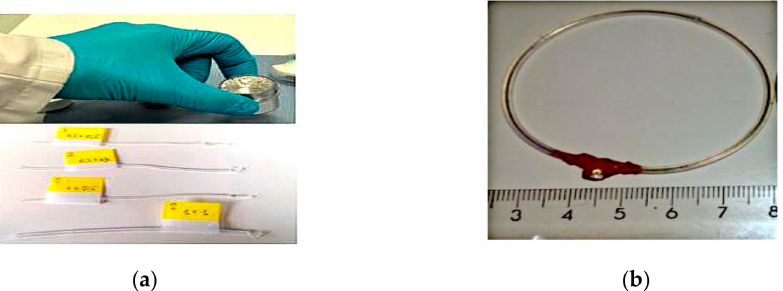
Figure 10. The proposed wearable antenna. ( a ) Galinstan and silicon tubing. ( b ) Loop antenna [47].